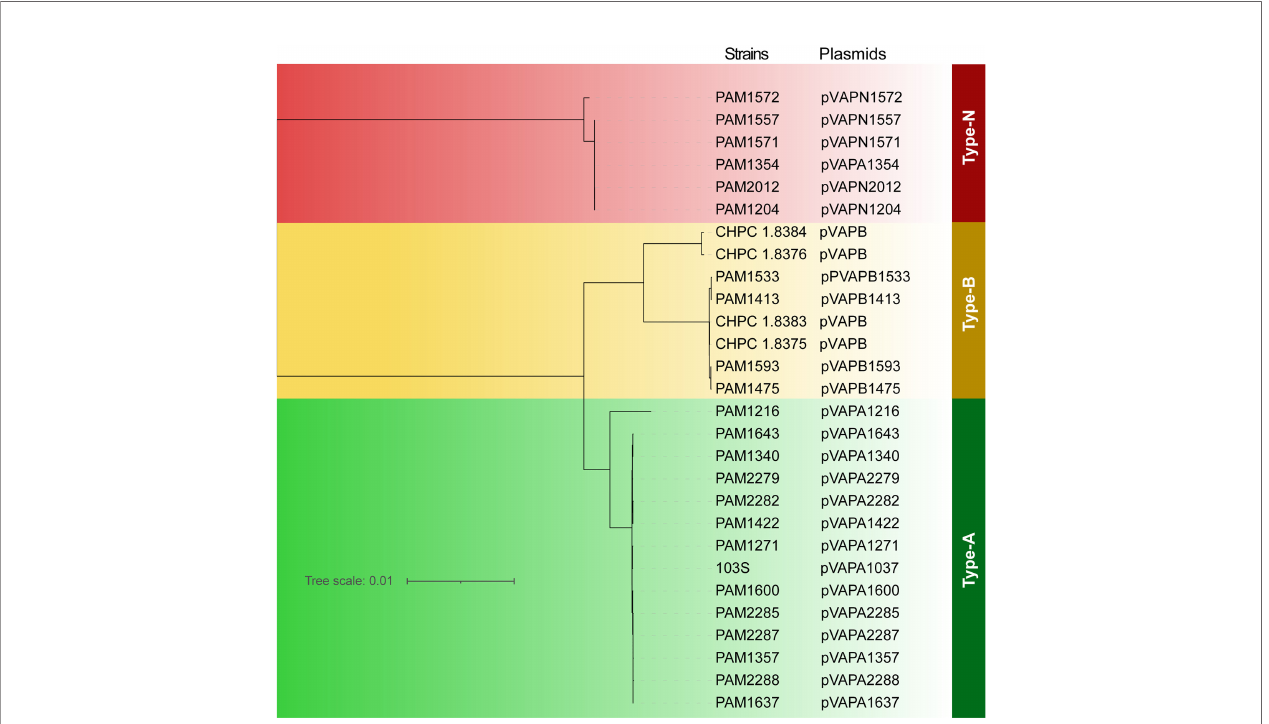
FIGURE 6 | Phylogenetic tree based on full-length sequences of R. equi plasmids. The names of strains and plasmids were shown on the right. Different types of plasmids were labeled in different colors. Green for type-A plasmid, yellow for type-B plasmid, and red for type-N